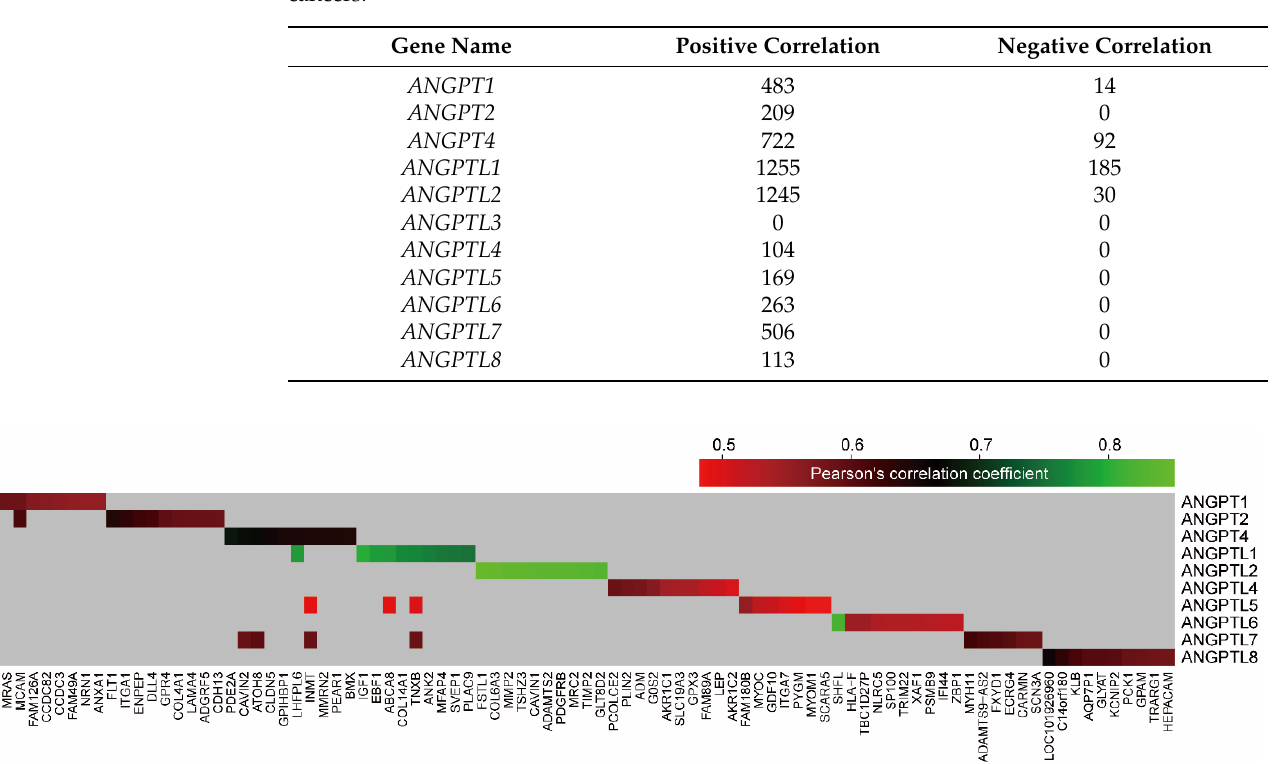
Table 3. Correlation between the expression level of ANGPT/ANGPTL genes and biological factors in the tumor microen- vironment of breast cancers . Table 2. The number of genes significantly co-expressed with ANGPT / ANGPTL genes in breast cancers.